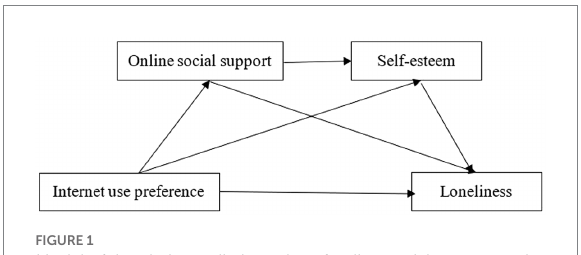
FIGURE 1 Model of the chain mediating roles of online social support and